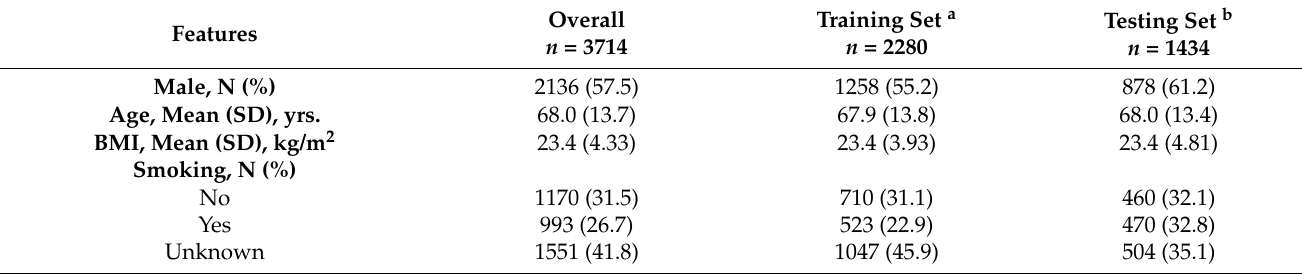
Table 1. Basic Characteristics of the Study